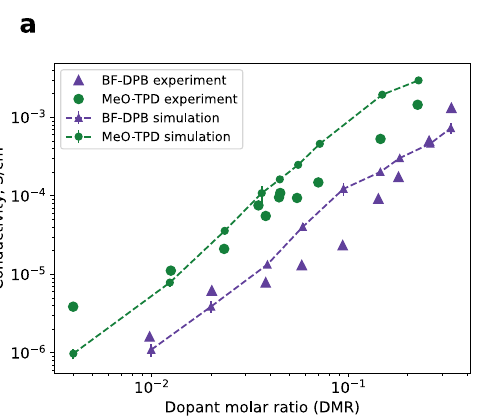
Fig. 4 | Experimental validation and the role of ICT state binding energy dis- order. a Dependence of the simulated conductivities on the dopant molar ratio of the systems BF-DPB:F 6 TCNNQ and MeO-TPD:F 6 TCNNQ in comparison to experi- ment. Simulations reproduce experimentally observed absolute values and the concentration dependence of the conductivity. Points and error bars denote the mean and standard error of the mean of 20 independent kMC simulations.